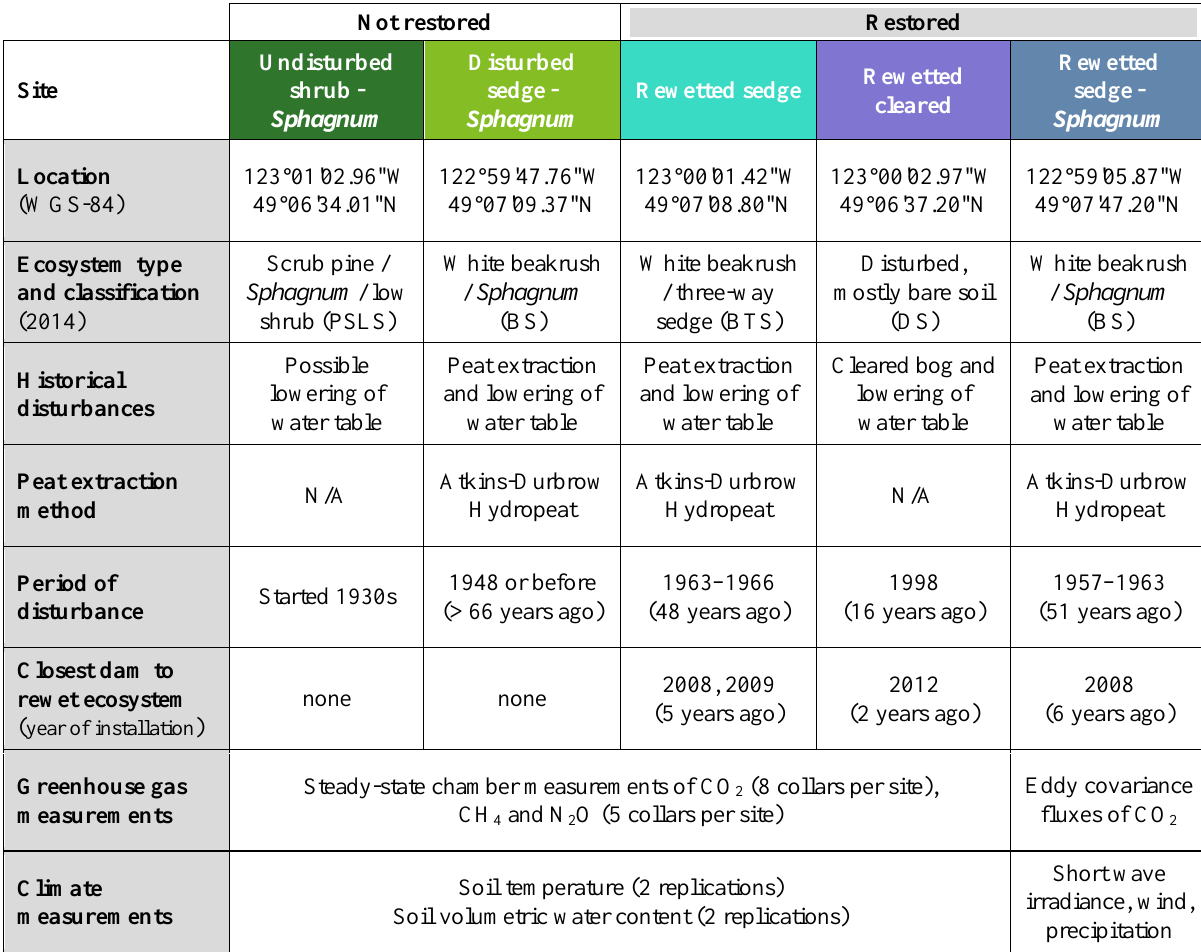
Table 1. Summary of all the measurement sites, their ecosystem characteristics, historical disturbances, locations and